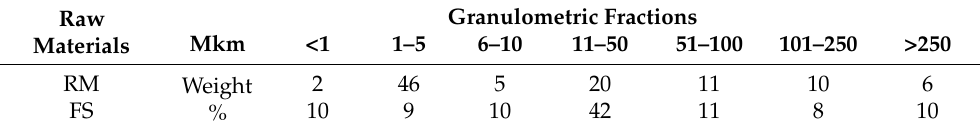
Table 6. Granulometric fractions of the